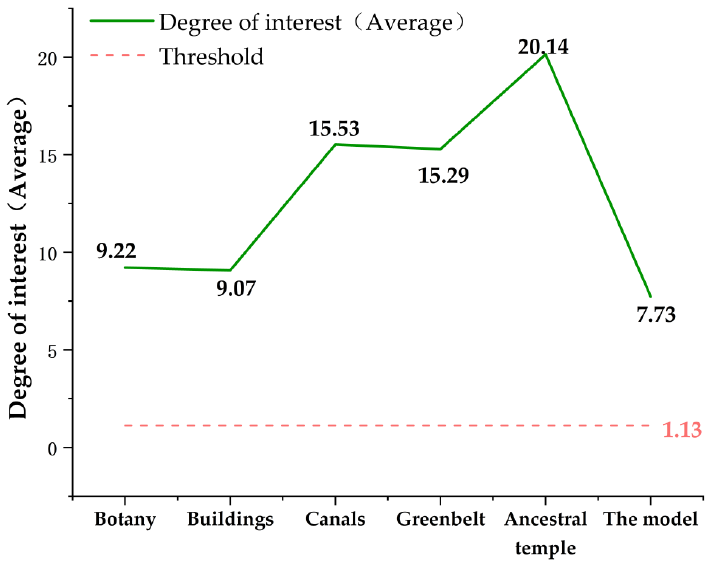
Figure 9. Comparison chart of interest trend. Source: Origin 2021 software production. The weight threshold of the interest degree was 1.13, and the maximum value of the interest degree was used to confirm that the subjects were most interested in the ancestral temple in the comparative analysis of the trend of interest degree changes.